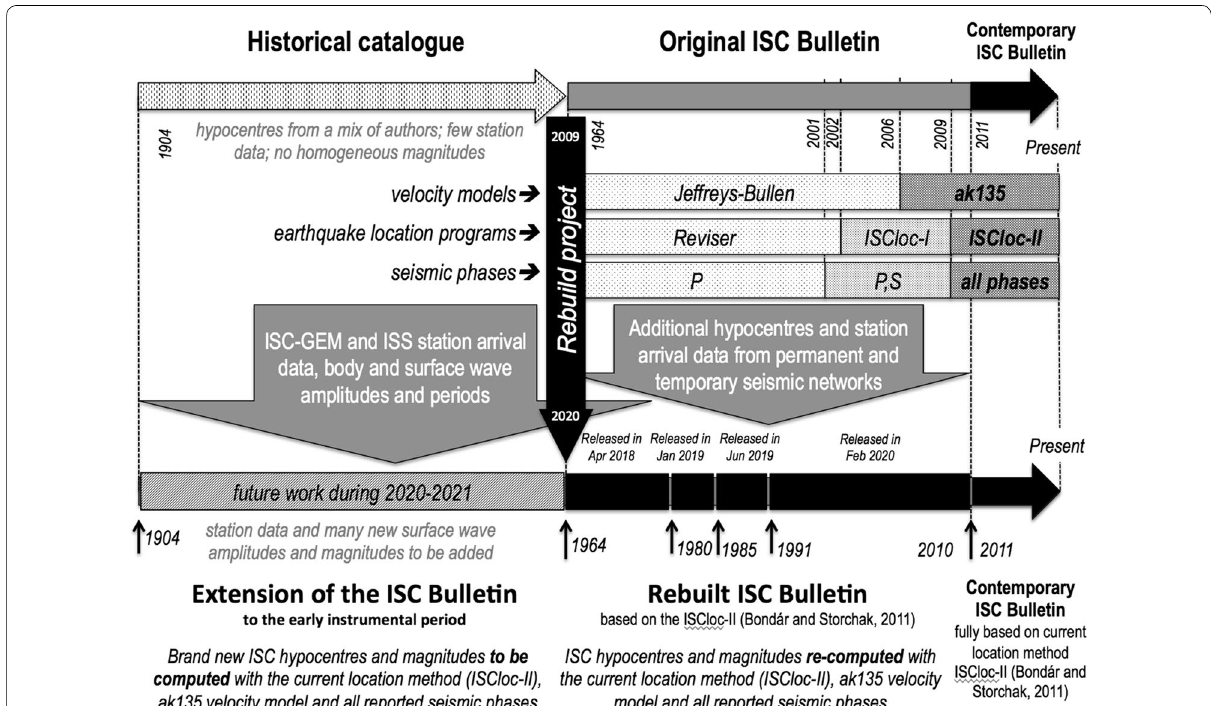
Fig. 16 An update on the overall status of the ISC Bulletin Rebuild project (Storchak et al. 2017) which shows the data available to ISC users in the past, today and in the future. Jeffreys-Bullen —seismic travel-time tables by Jeffreys and Bullen (1935, 1940); ak135 —1D velocity model by Kennett et al. (1995); Reviser and ISCloc-I are the operational earthquake location programs used at the ISC before the most recent program ISCloc-II (Bondár and Storchak, 2011) was introduced into